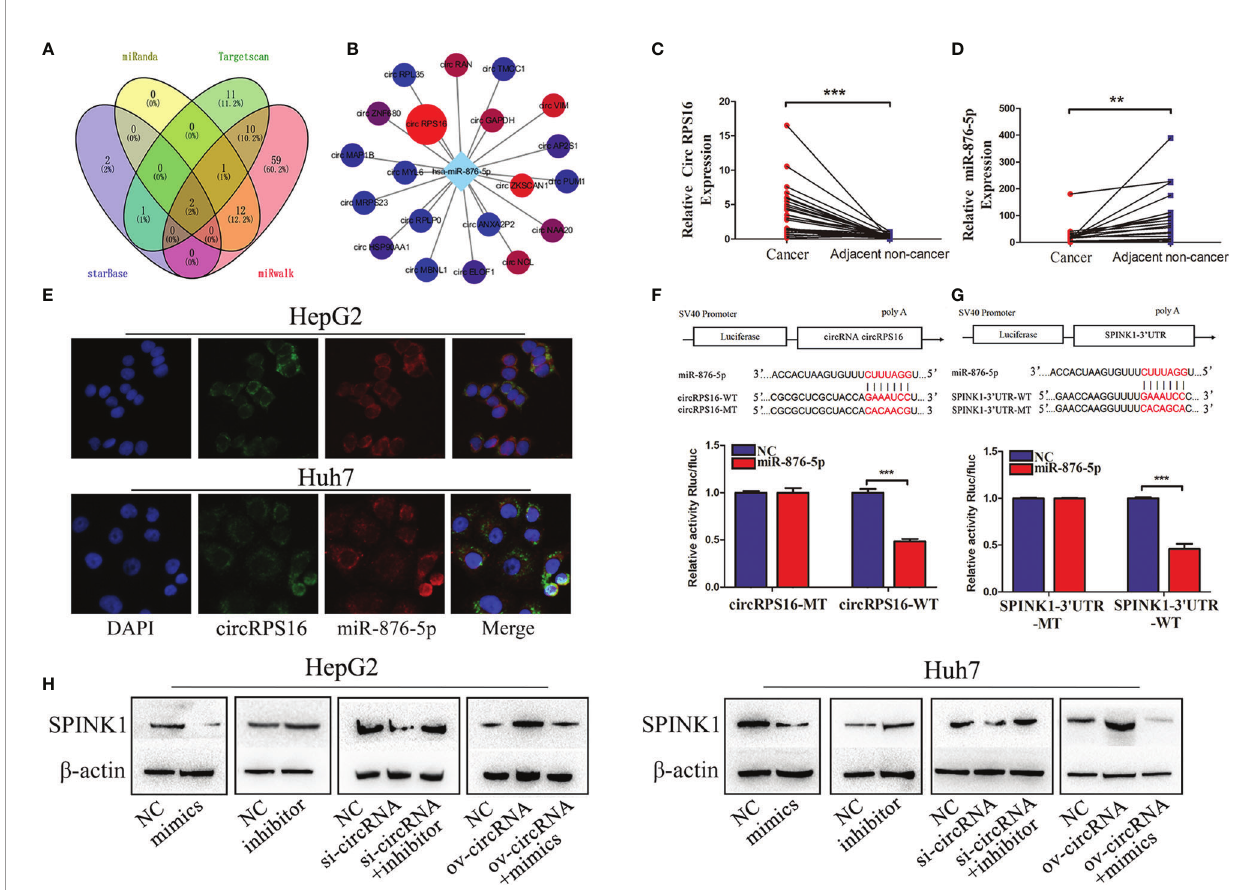
FIGURE 3 | circRPS16 regulates SPINK1 by sponging miR-876-5p. (A) The potential miRNA targeting SPINK1 were predicted by miRanda, Targetscan, starbase, and miRwalk database; the interaction is shown in the Venn diagram. (B) The potential circRNAs targeting miR-876-5p were predicted by starbase. (C) The circRPS16 and (D) miR-876-5p expression levels were quali fi ed by qRT-PCR. Data are presented as mean ± SD; statistical signi fi cance was assessed by paired t -test. ** p < 0.01, *** p < 0.001. (E) The location of circRPS16 and miR-876-5p was determined by FISH. (F) Dual-luciferase reporter assays demonstrated that circRPS16 directly targets miR-876-5p and (G) miR-876-5p directly targets SPINK1. Independent experiments were repeated three times; data are presented as mean ± SD; statistical signi fi cance was assessed by Student ’ s t -test. *** p < 0.001. (H) Western blot analysis shows that circRPS16 regulated SPINK1 expression via miR-876-5p. ov, overexpressed plasmid vector; si, siRNA; NC, negative